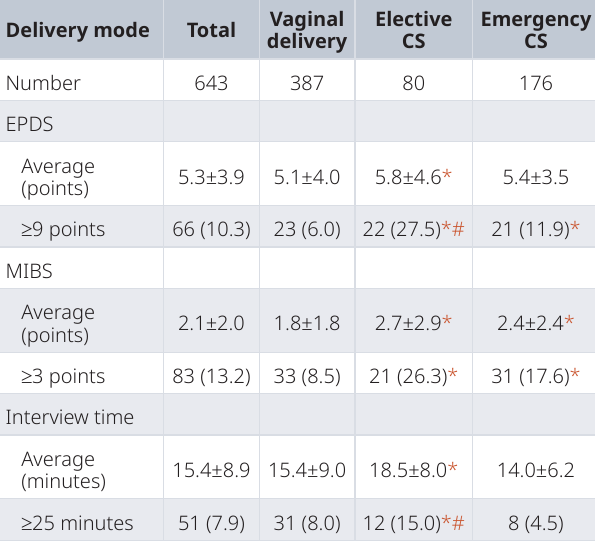
Table 1. One-month clinical evaluation for women who delivered a singleton baby between September 2018 and June 2019, overall and by method of